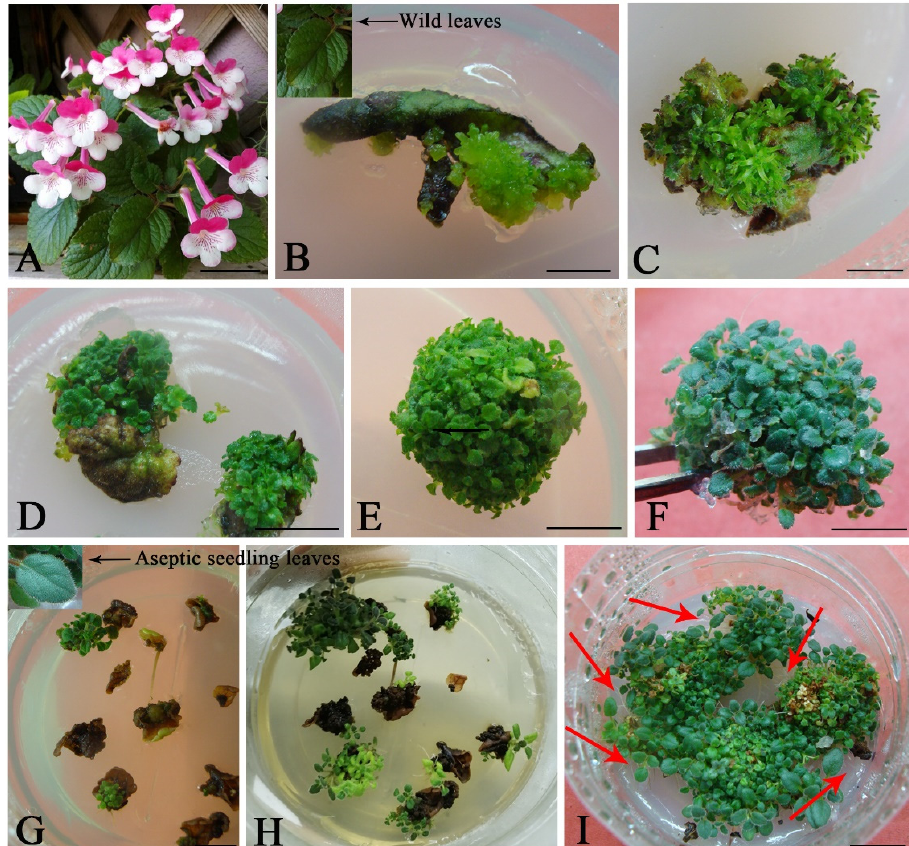
Figure 2. Direct adventitious shoot regeneration and proliferation from Sinningia hybrida ‘Isa’s Murmur’ leaf explants on MS medium supplemented with 2.0 mg · L − 1 BA and 0.1 mg · L − 1 NAA. ( A )